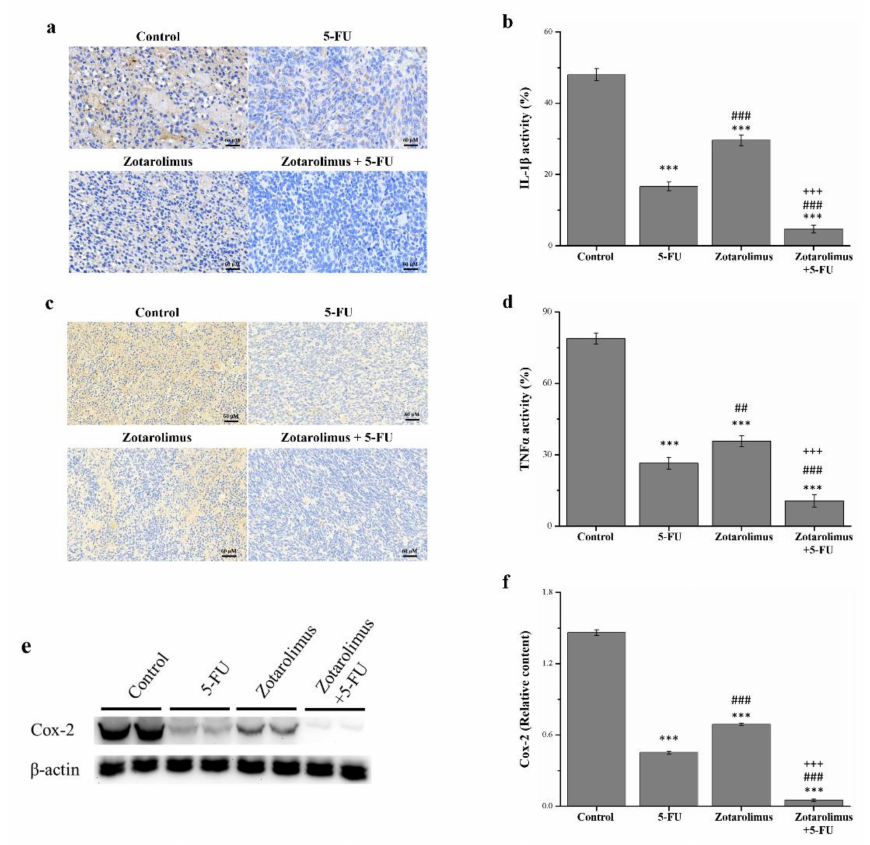
Figure 4. Immunohistochemical expression of ( a ) IL-1 β and ( c ) TNF- α in HCT-116 tumors from BALB/c nude mice and the comparative immunohistochemical expressions of ( b ) IL-1 β and ( d ) TNF- α . ( e ) Western blot analysis and ( f ) expression level of COX-2. All experiments were con- ducted on the HCT-116 tumor masses from BALB/c nude mice. Findings are reported for the control group and treatment groups: 5-FU (50 mg/kg/week), zotarolimus (2 mg/kg/day), and zotarolimus (2 mg/kg/day) combined with 5-FU (50 mg/kg/week). All data are presented as mean ± standard deviation, n = 8 per group. *** p < 0.001 compared with the control group. ## p < 0.01 and ### p < 0.001 compared with the 5-FU group. +++ p < 0.001 compared with the zotarolimus group. Scale bars = 60 µ